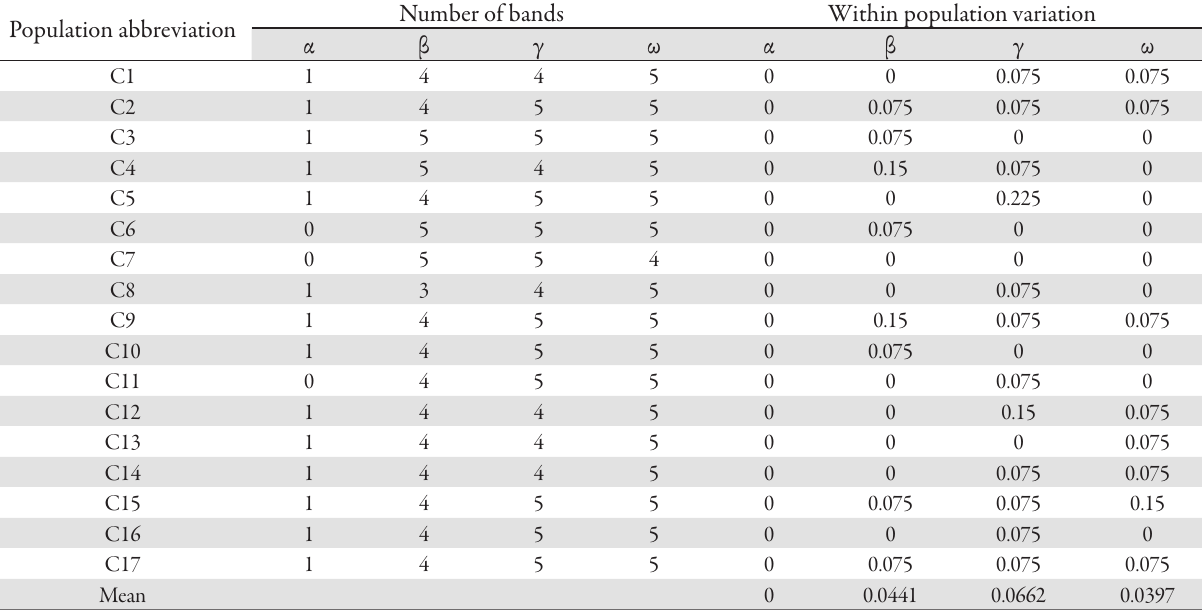
Population abbreviation